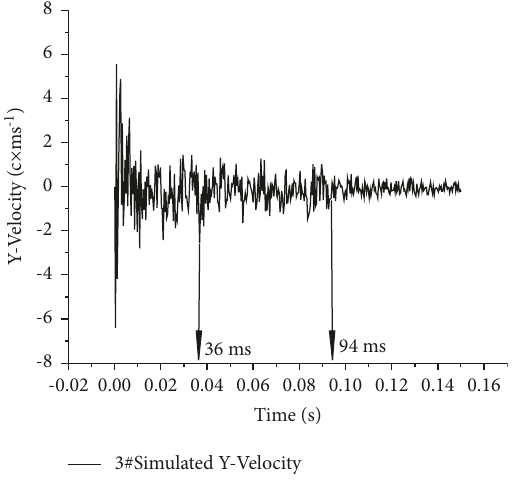
Figure 6: Simulated time course of Y-vibration velocity of 3# measuring point.